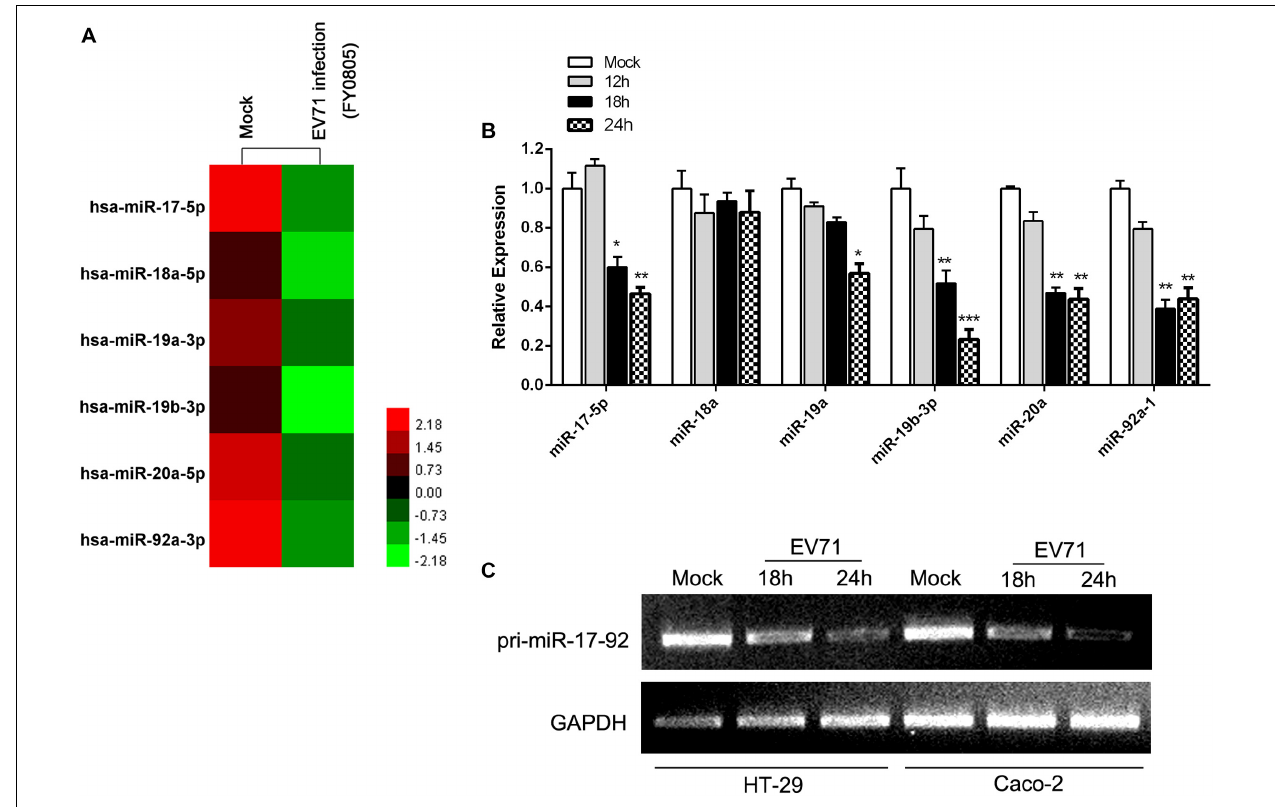
FIGURE 1 | EV71 infection downregulated miR-17-92 cluster. (A) The heatmap showed the expression level of members of miR-17-92 cluster in mock- and EV71-infected HT-29 cells by small RNA deep sequencing. (B) Expression of mature miRNAs of the miR-17-92 cluster was analyzed in EV71-infected HT-29 cells at indicated time points by real-time quantitative PCR, using U6 rRNA as an internal control. Values were mean of triplicate experiments and presented in relative to the level of the mock infection. Mock infection was assigned with a value of 1. The data were presented as mean ± SEM ( n = 3, ∗ P < 0.05, ∗∗ P < 0.01, ∗∗∗ P < 0.001). (C) RT-PCR analysis of the pri-miR-17-92 cluster expression in EV71-infected cells at indicated time points normalized against GAPDH transcript